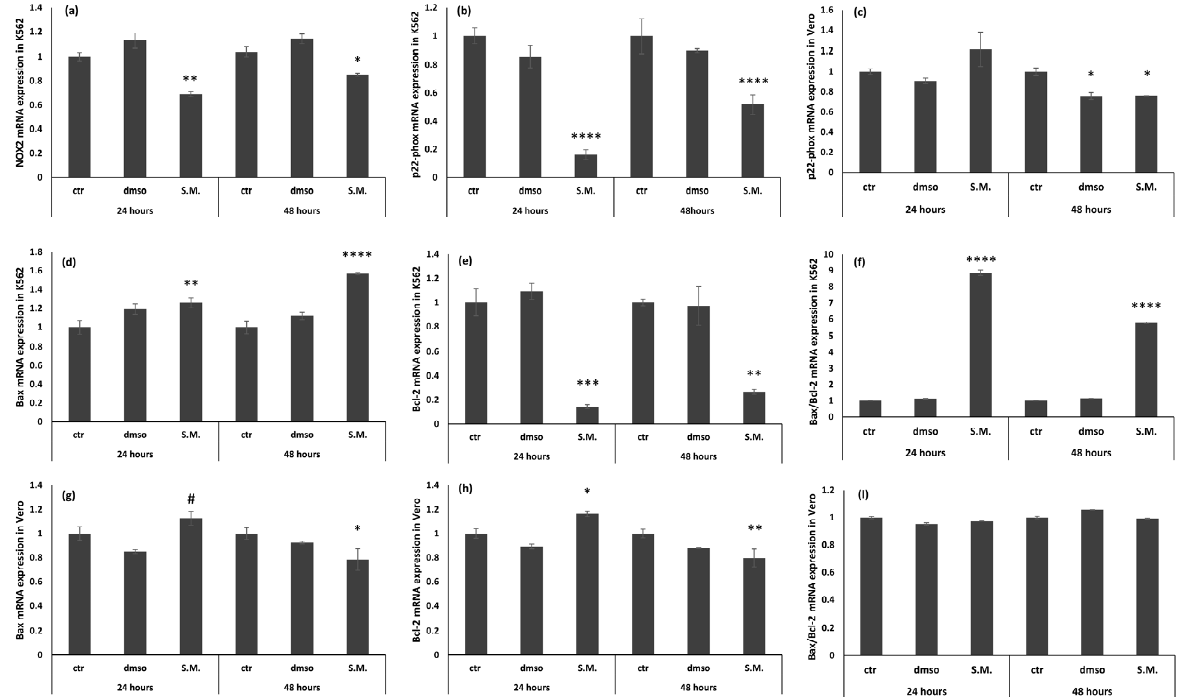
Figure 7. Effects of Skeletonema marinoi (S.M.) extract (0.75 mg/mL) on NOX2, p22-phox, Bax, Bcl-2, and Bax/Bcl-2 ratio mRNA expression in K562 cells and Vero cells. ( a ) NOX2 mRNA expression in K562; ( b ) p22-phox mRNA expression in K562; ( c ) p22-phox mRNA expression in Vero; ( d ) Bax mRNA expression in K562; ( e ) Bcl-2 mRNA expression in K562; ( f ) Bax/Bcl-2 ratio mRNA expression in K562; ( g ) Bax mRNA expression in Vero; ( h ) Bcl-2 mRNA expression in Vero; and ( i ) Bax/Bcl-2 ratio mRNA expression in Vero. Data are expressed as mean ± standard deviation (SD) of three experiments and compared with t -test (* p < 0.05 versus control cells; ** p < 0.01 versus control cells; *** p < 0.001 versus control cells; **** p < 0.001 versus control cells; # p < 0.05 versus dmso treated cells).